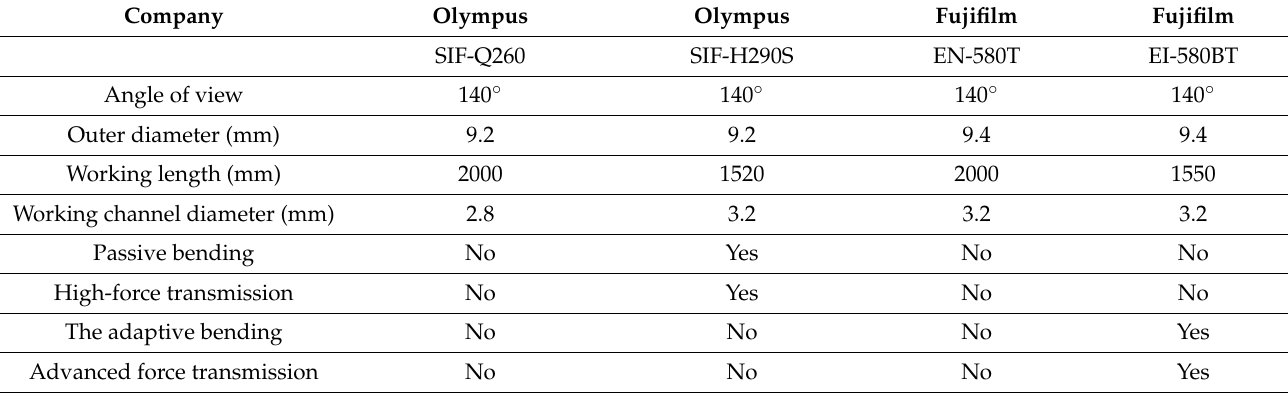
Table 1. Specifications of single-balloon enteroscopy (SBE) and double-balloon enteroscopy